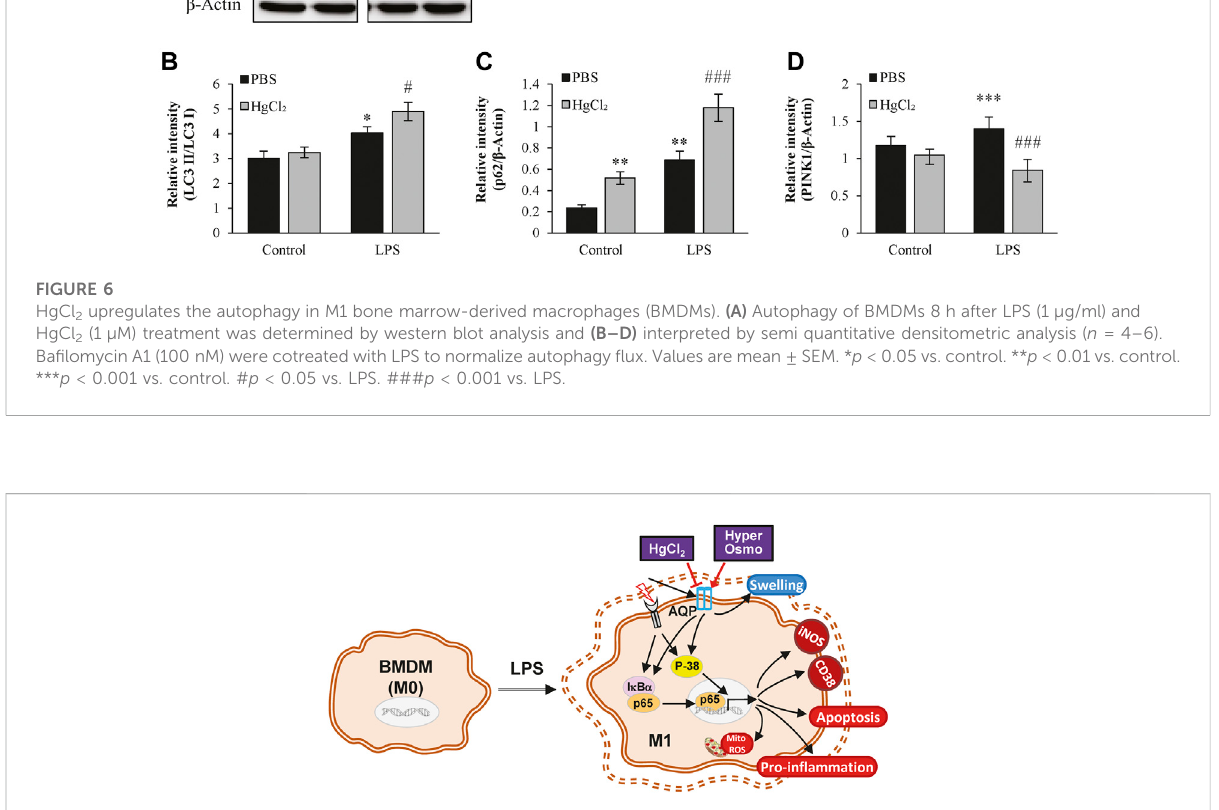
FIGURE 7 The schematic diagram of the effect of HgCl 2 on bone marrow-derived macrophages in in fl ammatory response. The stimulation from LPS triggers the M1 polarization of BMDMs, activating the in fl ammatory cascade and causing the swelling of the cell. Although hypertonicity and HgCl 2 induction are both able to restrict cell enlargement, the AQP inhibition effect of HgCl 2 can signi fi cantly reduce the M1 phenotype of BMDMs. HgCl 2 suppress the NF- κ B activation mainly through the downregulation of p38/MAPK pathway, reducing the translocation of NF- κ B into nucleus. Elevated autophagy levels may also help to recycle over-activated mitochondria, preventing mitochondrial ROS stress, and maintaining cell metabolic